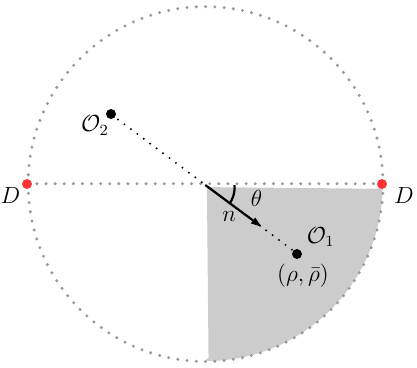
Figure 3 . The con(cid:12)guration corresponding to eq. (2.20). The defect is spherical and orthogonal to the plane drawn in the (cid:12)gure, and crosses it at the position marked by the red dots. The operators and sit at the same radius r , and the position of O 1 O 2 complex coordinates ( (cid:26); (cid:22) (cid:26) ). The fundamental domain